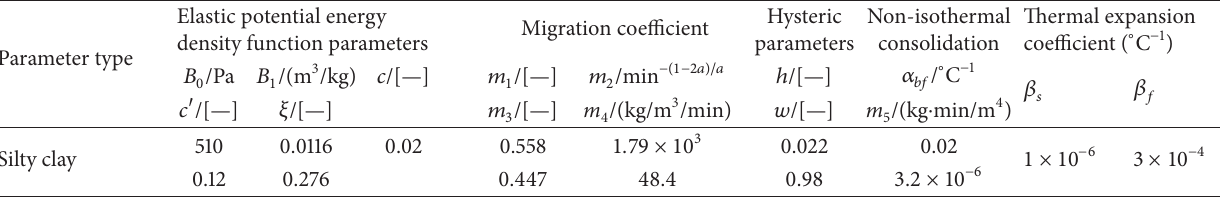
Table 1: List of the main parameters used in this paper.